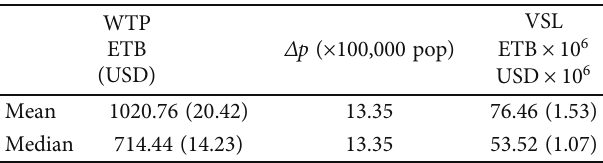
(b) Bootstrap con fi dence interval for log-logistic model Figure 3: The simulated mean, median, truncated mean, and adjusted truncated mean of the WTP empirical distribution (source: authors). Table 14: VSL in Ethiopia ( 1USD = 50ETB as of February 2022, according to the National Bank of Ethiopia) (source: